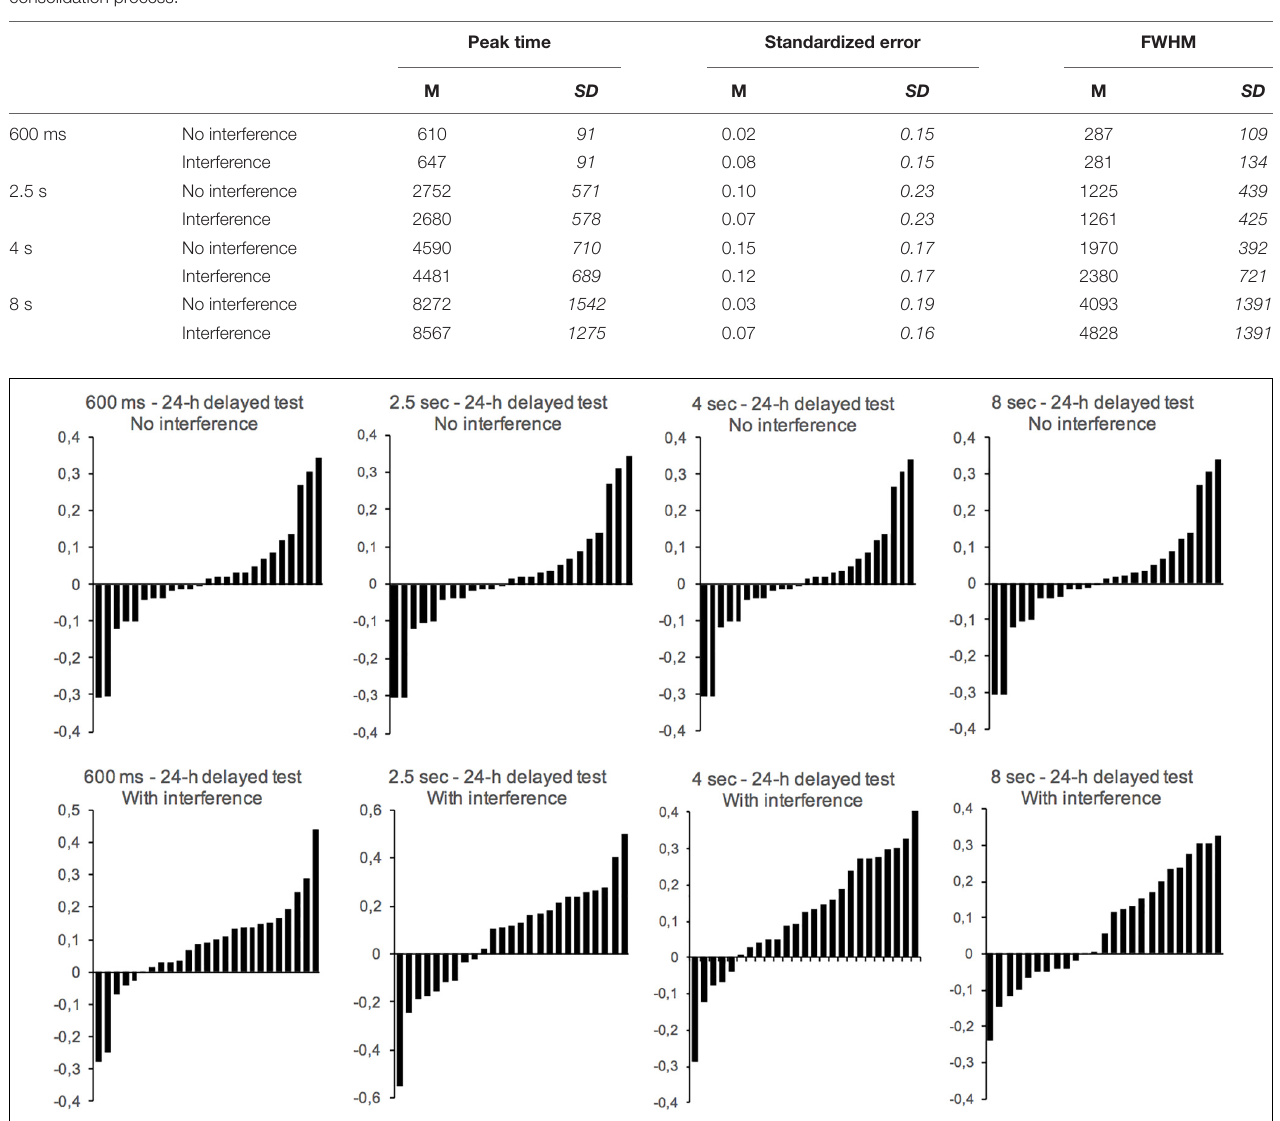
FIGURE 4 | Distribution of individual standardized errors in the long-term memory test with (bottom panels) or without (top panels) an interference task for the 600-ms, 2.5-s, 4-s, and 8-s duration groups (one panel per group). Each bar represents one